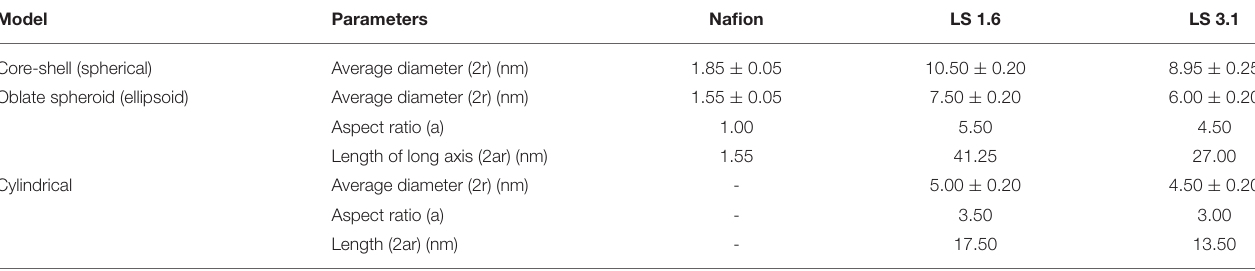
200–250 nm-thick Nafion, LS 1.6, and LS 3.1 films at 60% RH obtained by fitting ionic domain peaks (RSAXS) using ∼